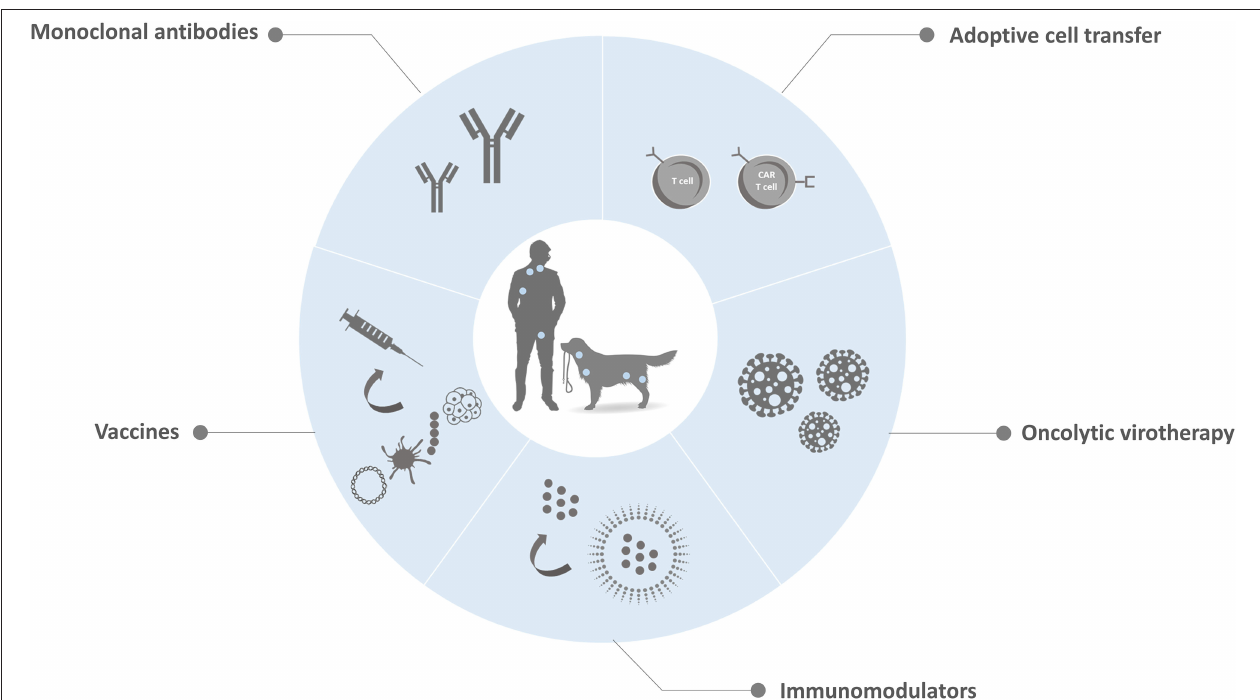
FIGURE 1 | Schematic representation of available and under development immunotherapy strategies for cNHL. Currently, several research groups are actively investigating new immunotherapies that mobilize the patient’s own immune system to treat NHL in both pets and pet owners. These treatment modalities include therapeutic mAbs that promote the direct or indirect death of cancer cells, adoptative cell transfer that uses a patient’s own cells to induce antitumor activity, oncolytic virotherapy that involves the replication-competent virus in the elimination of cancer, immunomodulators that aim to enhance immune responses and tumor control and vaccines that stimulate a patient’s own immune system against cancer